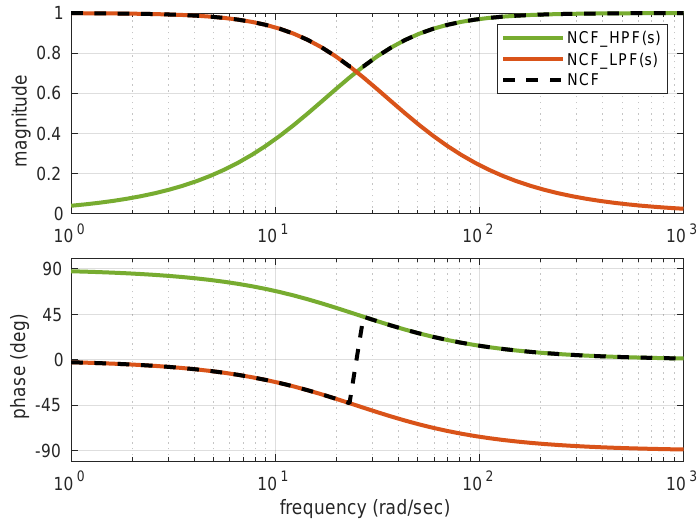
Figure 4. Amplitude and Phase plot for